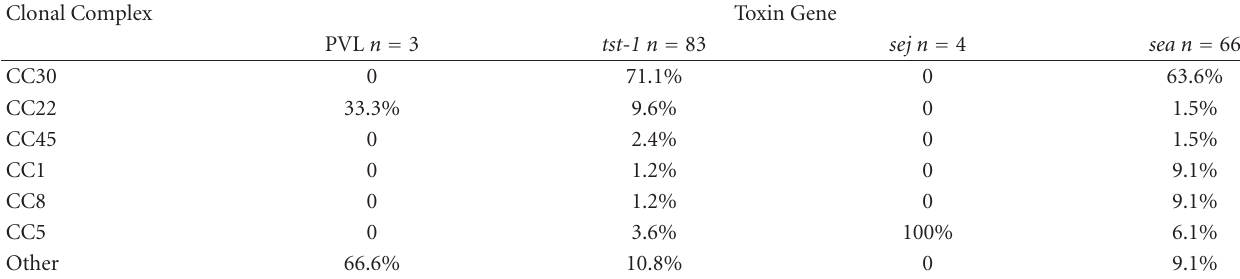
Table 5: The distribution of toxin genes within the 6 dominant S. aureus